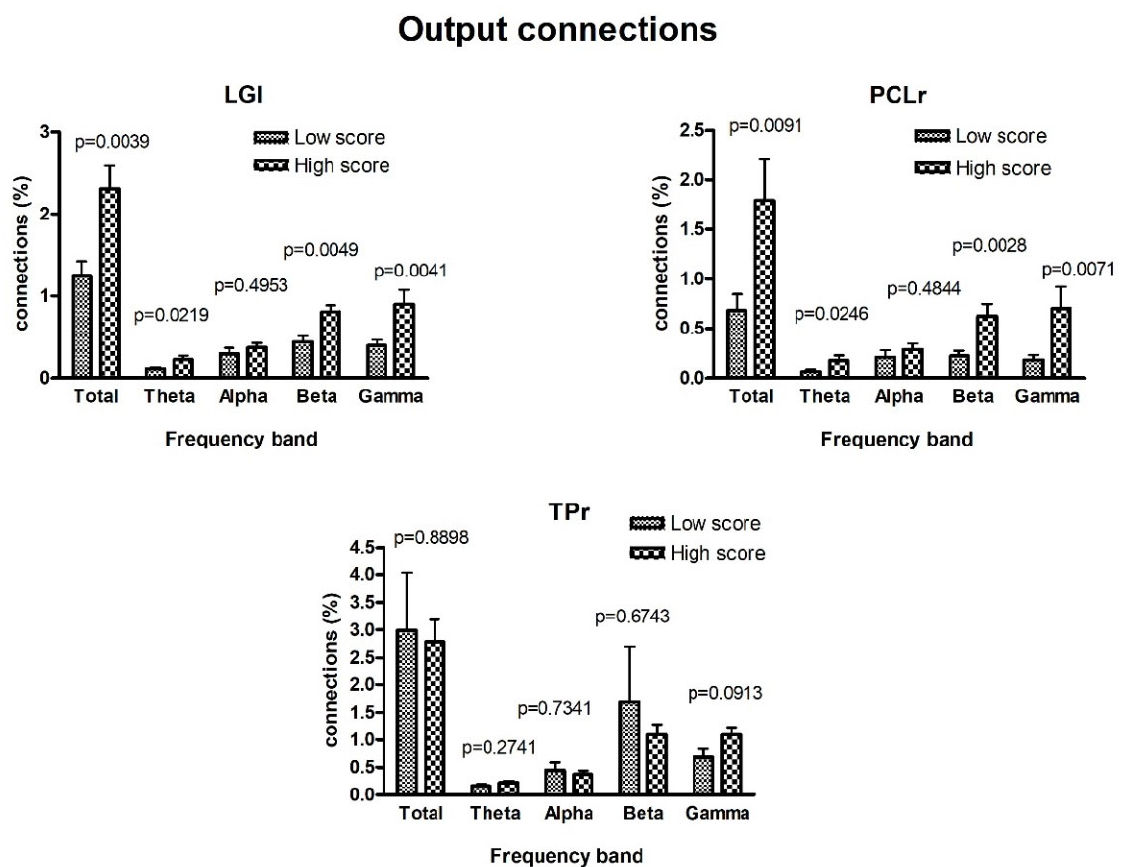
Figure 3. Comparison between the normalized connections exiting from a given region ROI i in the two classes of subjects with lower and higher AQ scores, obtained using the spectral Granger connectivity. The comparison is performed using the overall connectivity computed in the entire frequency range ( sGC tot k , ROI i → ROI j ) and the connectivity in the individual bands, with reference to the three regions defined as AQ ‐ modulated source ROIs in Figure 1. Note that differences in TPr are not significant using spectral Granger causality instead of the temporal Granger causality. Moreover, differences in LGl and PCLr are highly significant in the beta and gamma bands, but not in the alpha band.